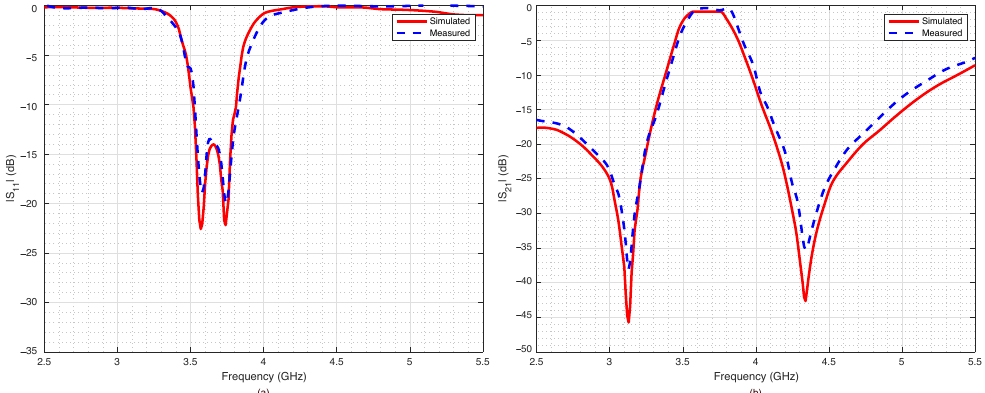
Figure 16. Simulated vs. measured scattering parameters of the pseudohairpin filter prototype: ( a ) return loss S 11 , ( b ) insertion loss S 21 . RF-MEMS switches configuration 011.